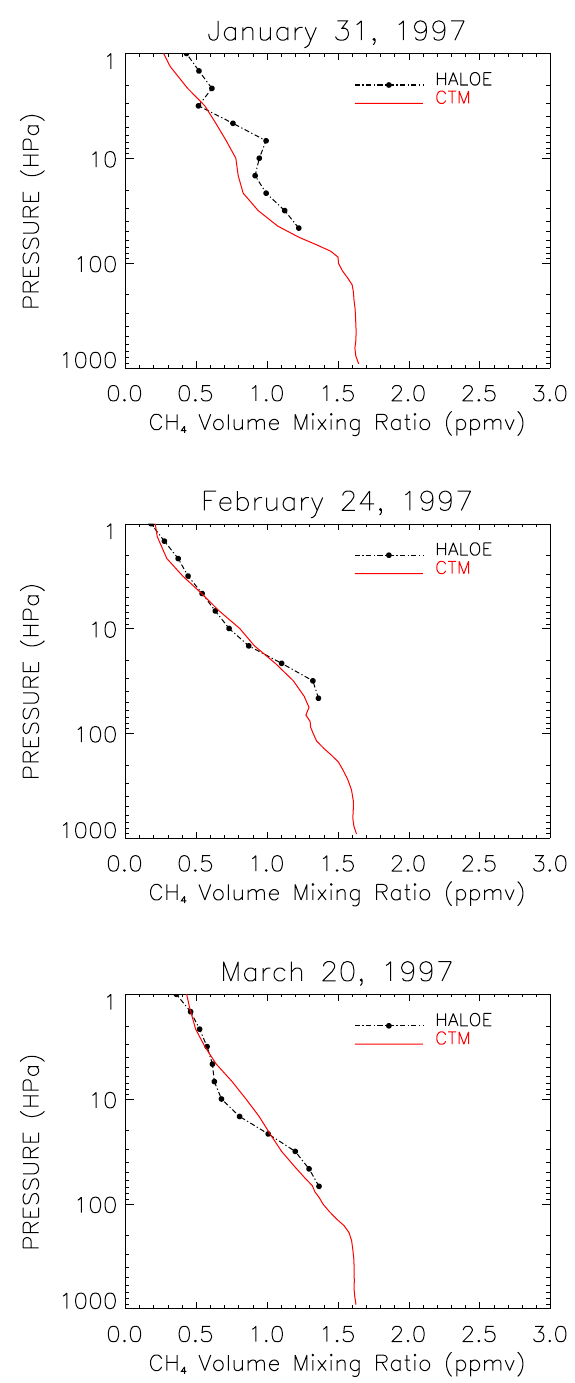
Fig. 6. CH 4 profiles observed by HALOE and modeled with CTM for (from top to bottom): 31 January 1997 at 276 ◦ E and 35 ◦ N; 24 February 1997 at 275 ◦ E and 47 ◦ N; 20 March 1997 at 259 ◦ E and 48 ◦